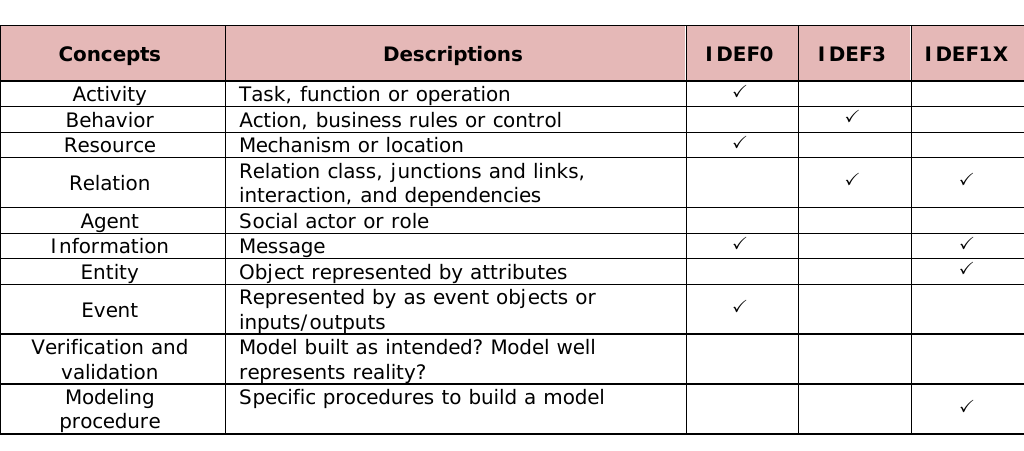
Table 1. “Business concepts vs. IDEF